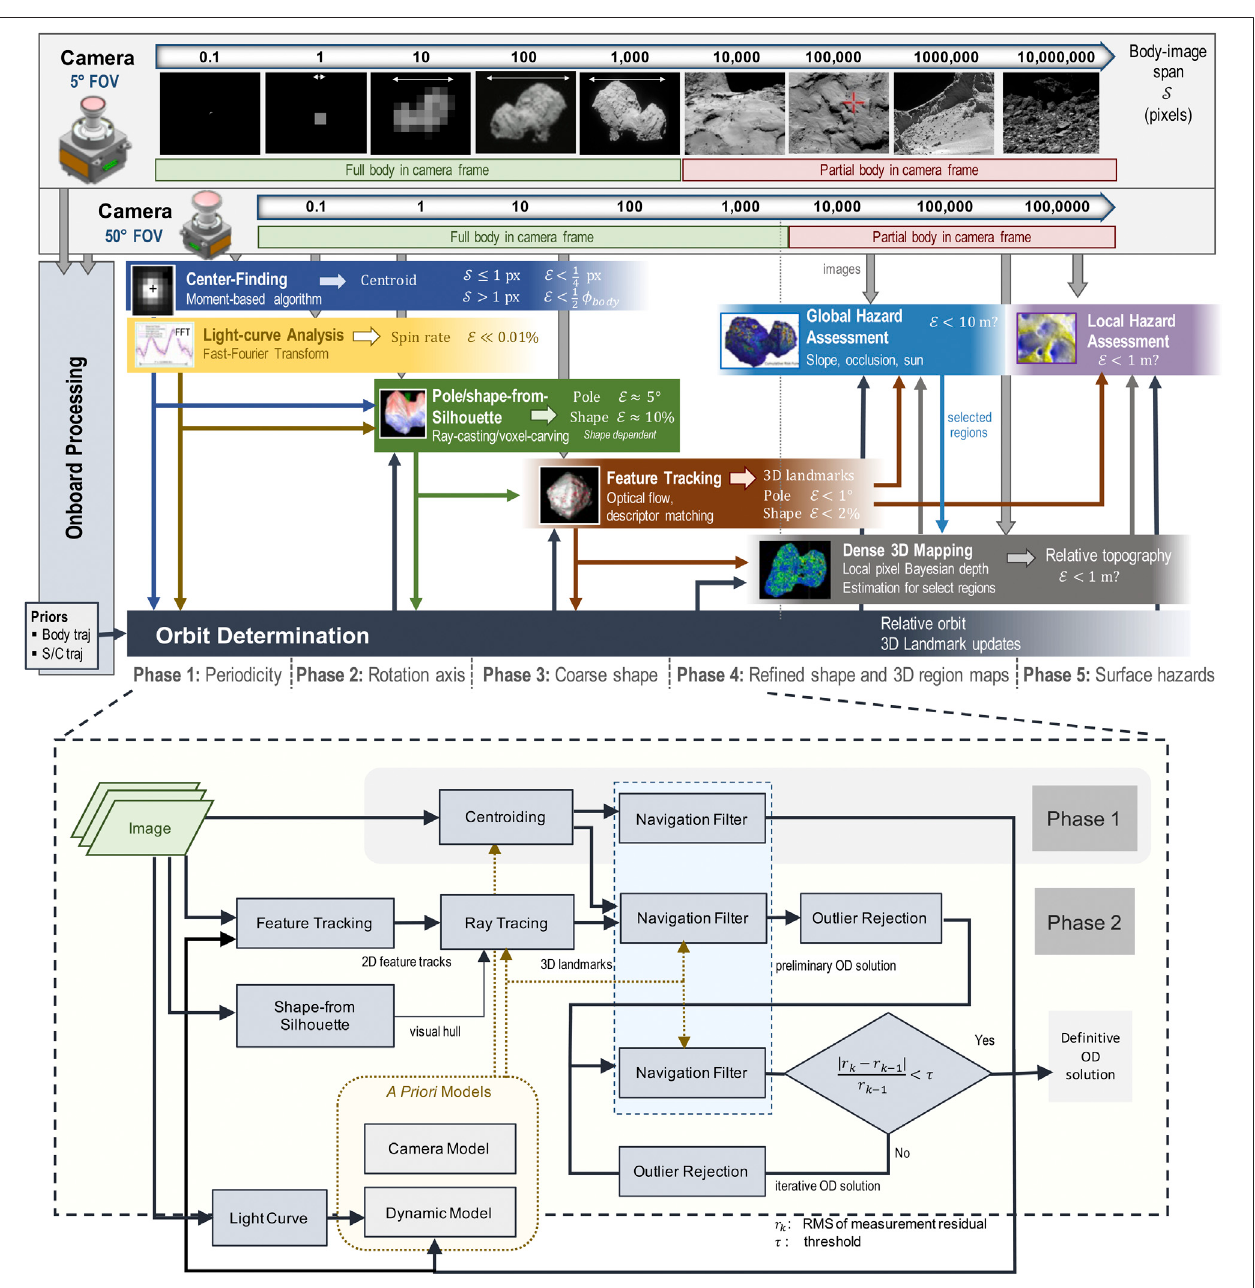
FIGURE 1 | Multi-phase single-spacecraft and target body estimation framework (A) with details of the autonomous orbit determination process (B) .